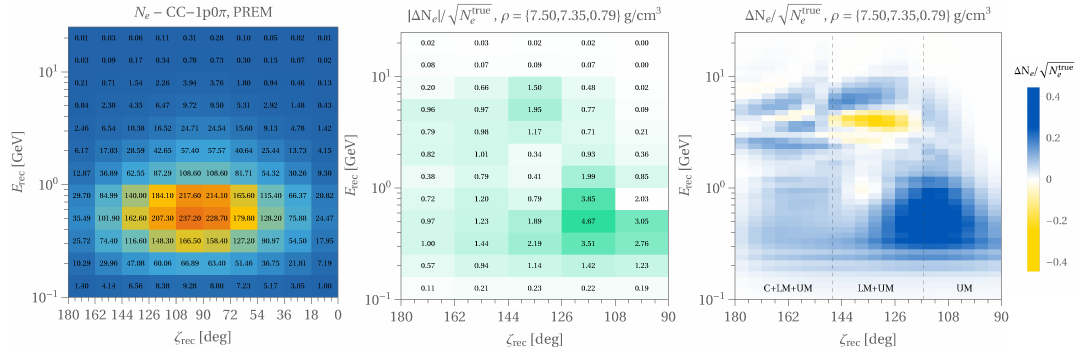
Figure 16 . Left : number of charged current electron neutrino events with one proton and no pions in the final state(CC-1p0 π ) for an exposure of 400 kt-yr, taking into account cross section and detector effects, as a function of the reconstructed neutrino energy and zenith angle, assuming δ CP = 0 . 65 π and NO. Middle : statistical power of CC-1p0 π sample, see text for details. Right : statistical power of CC-1p0 π sample for the 40 × 60 binning used in our simulations; the darkest p blue and yellow correspond to ∆ N = 0 . 33 , − 0 . 25 , N true e / e